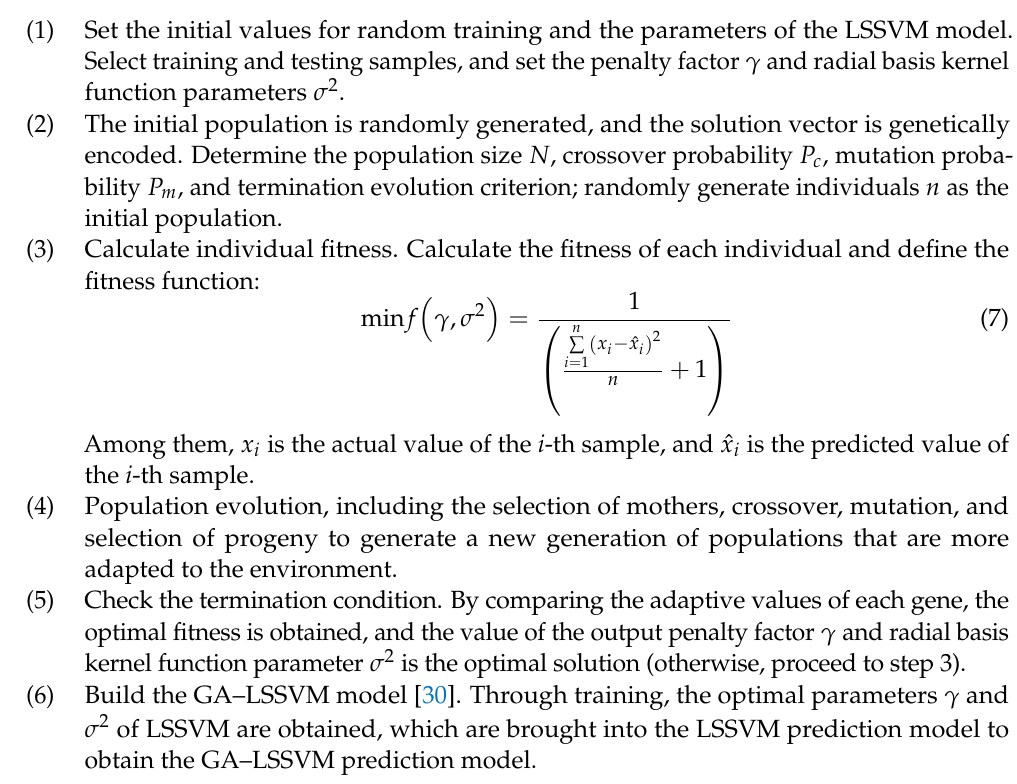
Figure 2. GA–LSSVM algorithm flow chart.